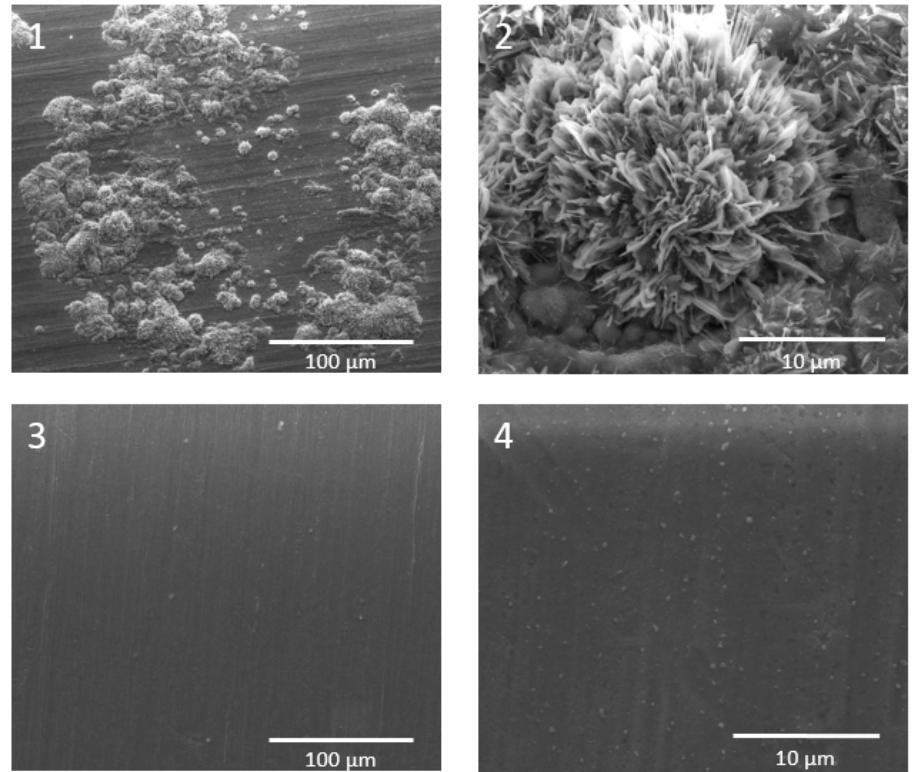
Figure 8. Comparison of ferritic stainless-steel samples in dual atmosphere ( 1 and 2 ) and single/dry air atmosphere ( 3 and 4 ).